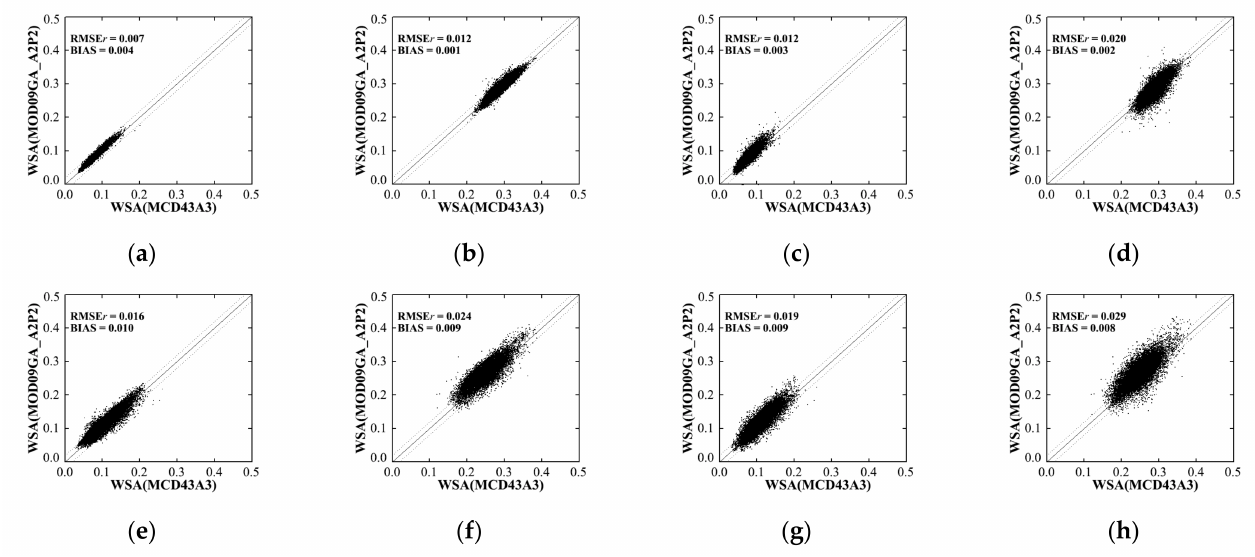
Figure 15. Scatter plot of MODIS albedo and albedo retrieval from MODIS observations and archetype A2P2: ( a – d ) are based on the observations within 101-116 and ( e – h ) are based on observations within 305-320; ( a , b , e , f ) refer to multi-angular observations; ( c , d , g , h ) refer to a single directional reflectance; ( a , c , e , g ) are the result of the red band; and ( b , d , f , h ) are the NIR